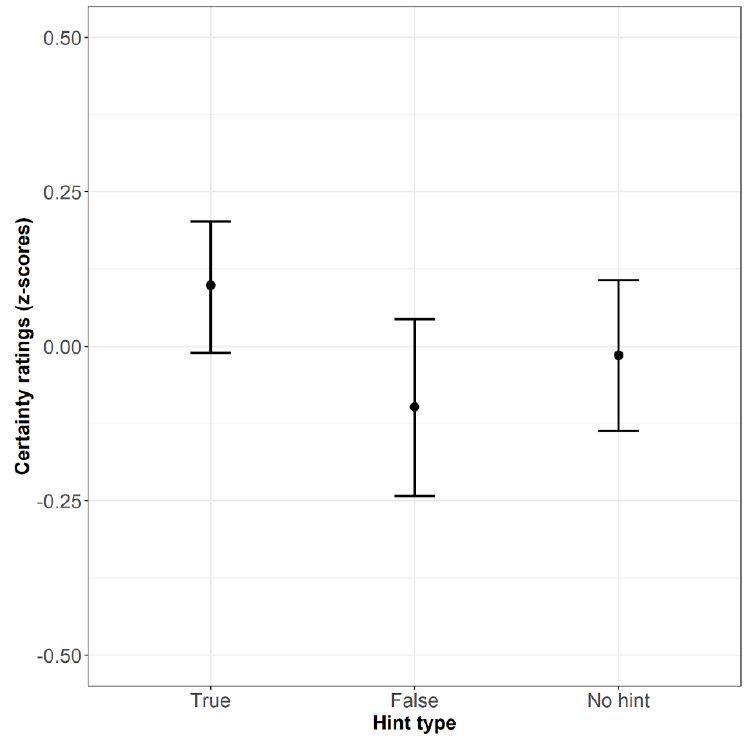
Figure 5. The mean certainty ratings (z-scores) across conditions (Bars refer to 95% confidence intervals).